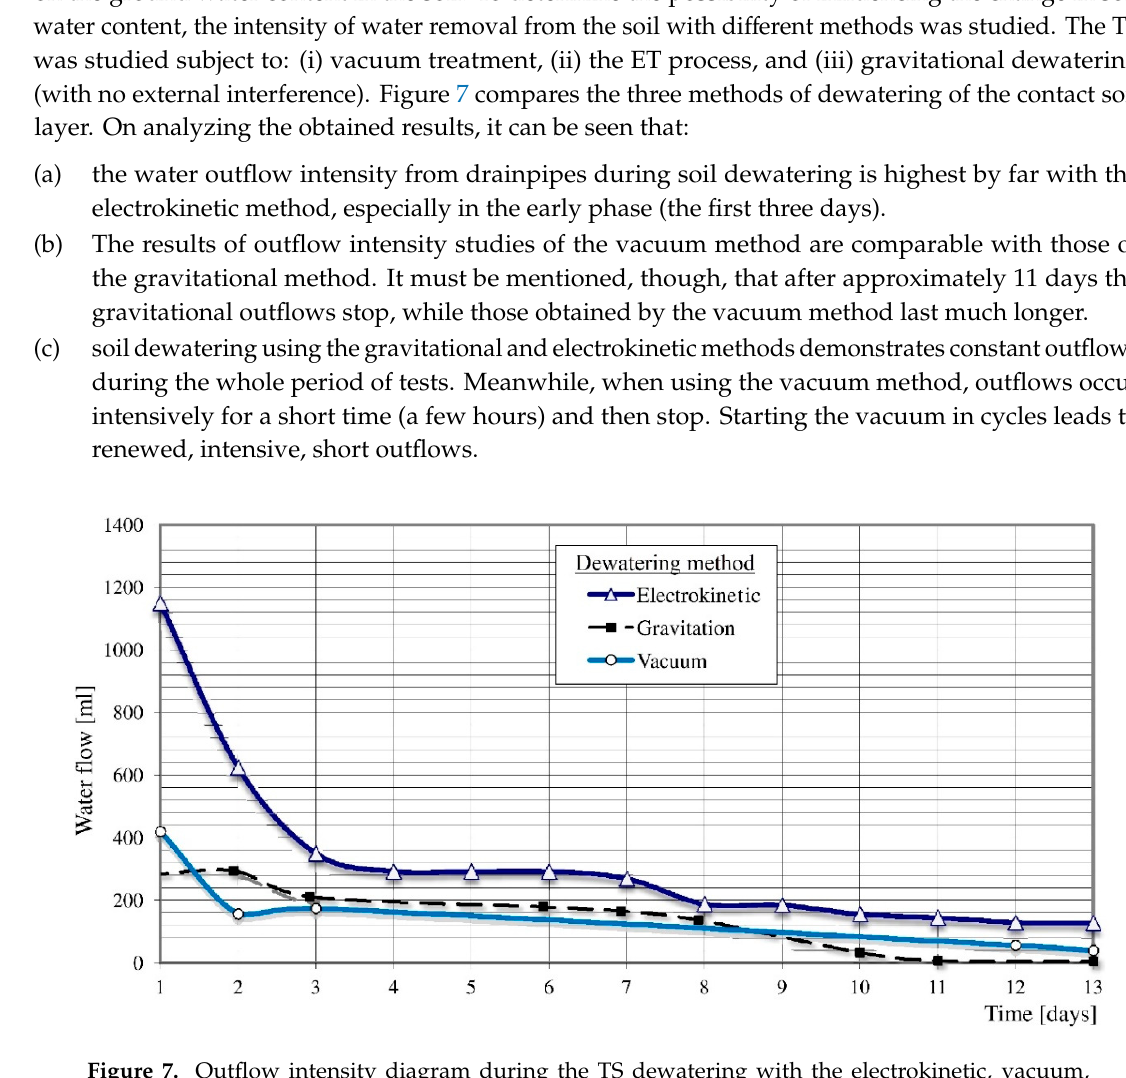
Figure 7. Outflow intensity diagram during the TS dewatering with the electrokinetic, vacuum, and gravitational methods.